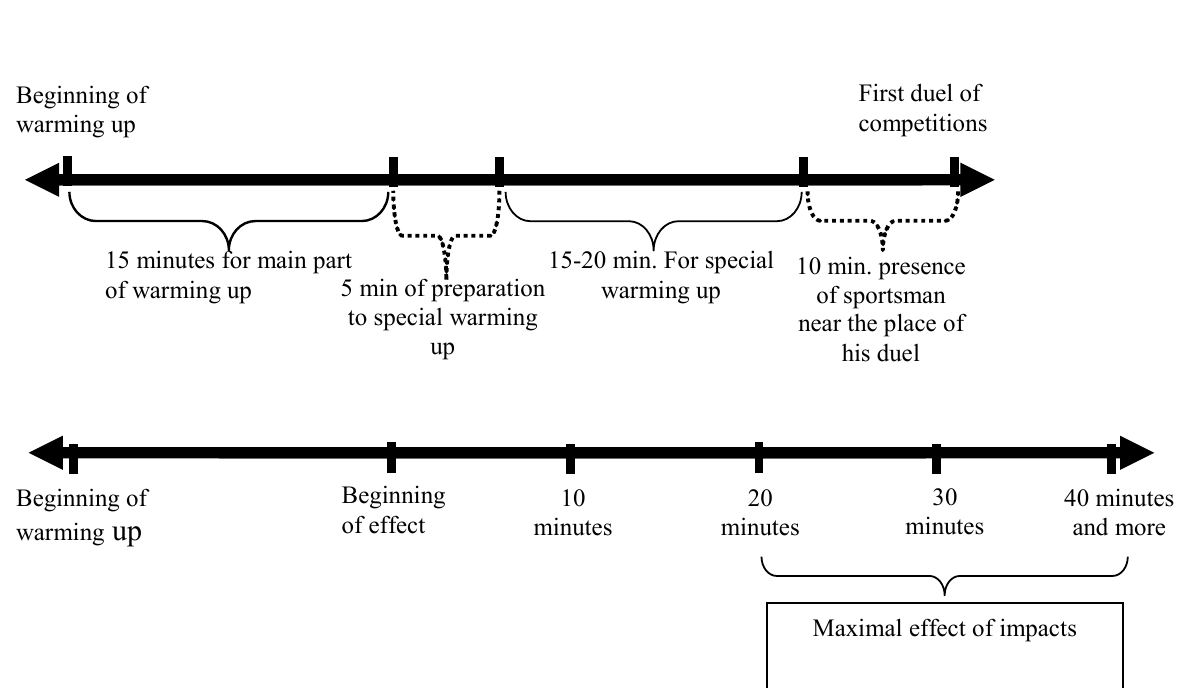
Fig.2. Specific features of application of pre-start impacts’ experimental